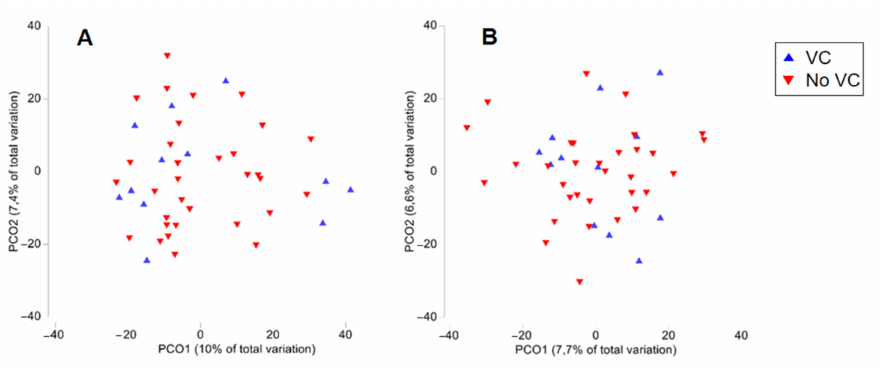
Figure 1. Principal coordinates analysis (PCO) of gut ( A ) and blood ( B ) microbiome in chronic kidney disease patients on peritoneal dialysis with vascular calcification (VC) or without vascular calcification (No VC).